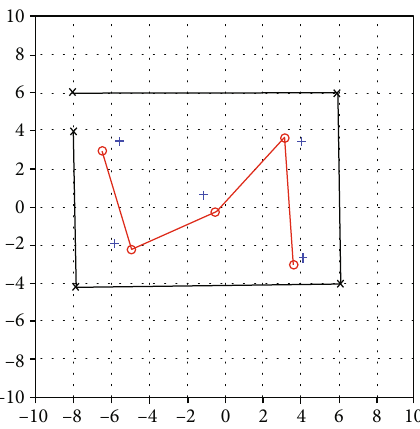
Figure 9: Environment diagram of experiment 1.